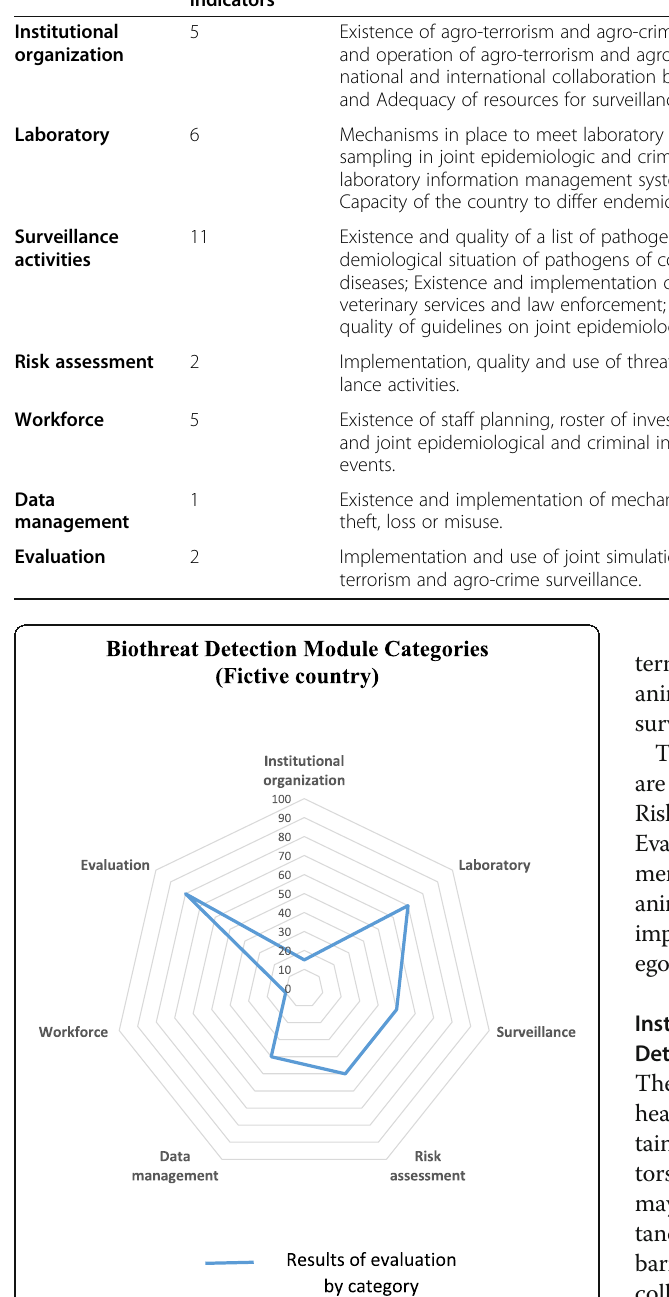
Table 4 Overview of SET Biothreat Detection Module categories and indicators Category